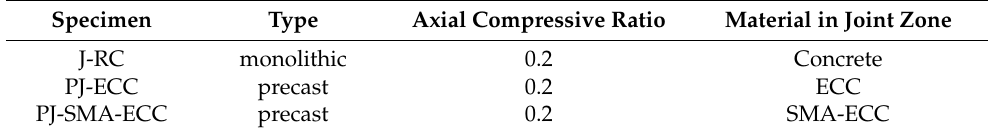
Table 1. Specimen beam–column joint details.